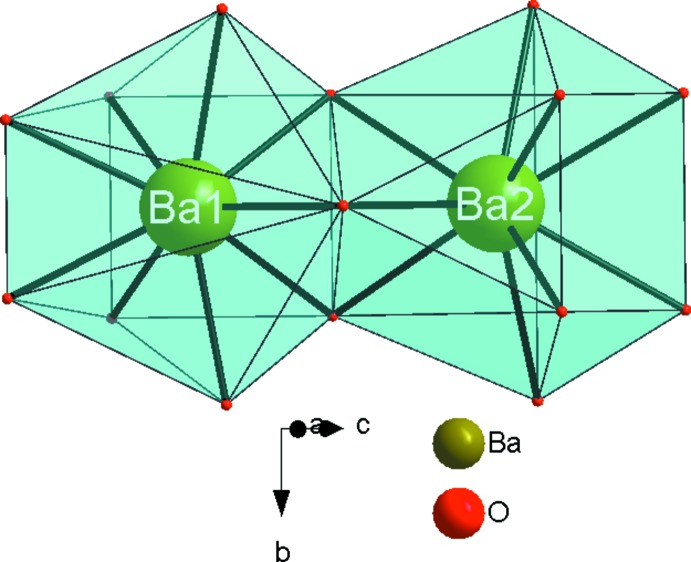
A pair of [BaO9] polyhedra.